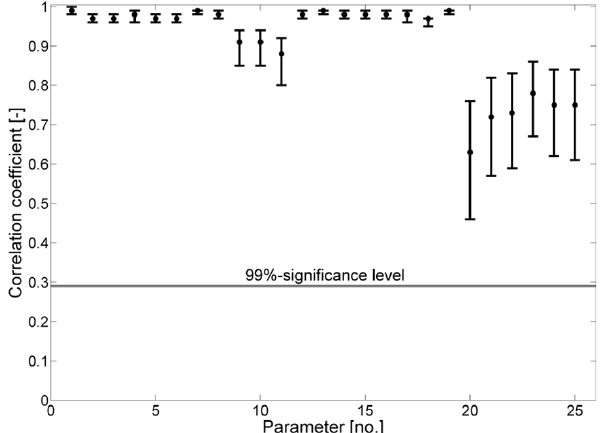
Fig. 3. Correlation coefficients for the 25 storm surge parameters calculated based on the parameter time series from the tide gauges of H¨ornum and Westerland and 99%-significance level from t -test